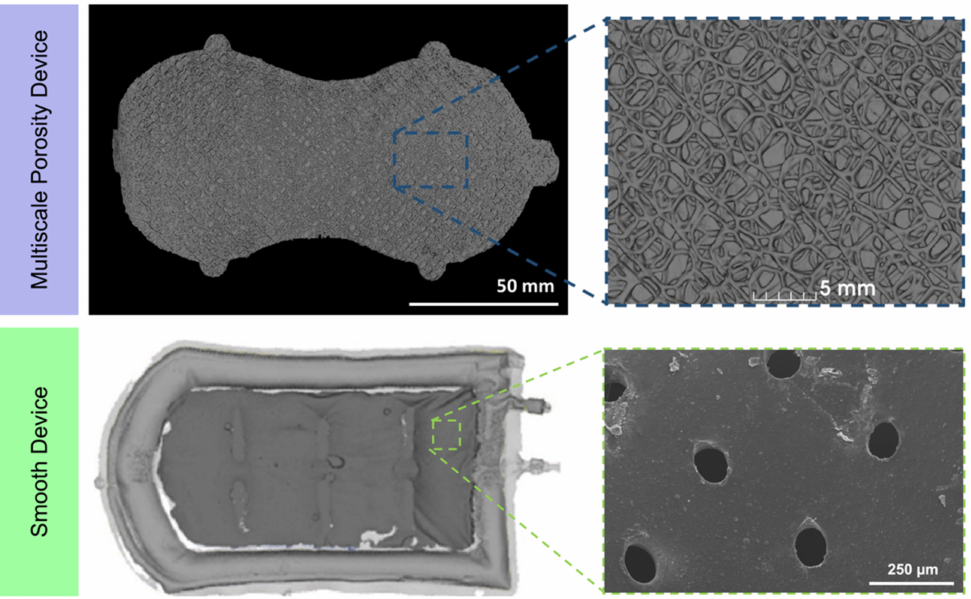
Figure 1. Volumetric renderings of devices after microCT imaging with associated high magnification images demonstrating both multiscale porosity surface [5] and smooth surface [4], respectively.